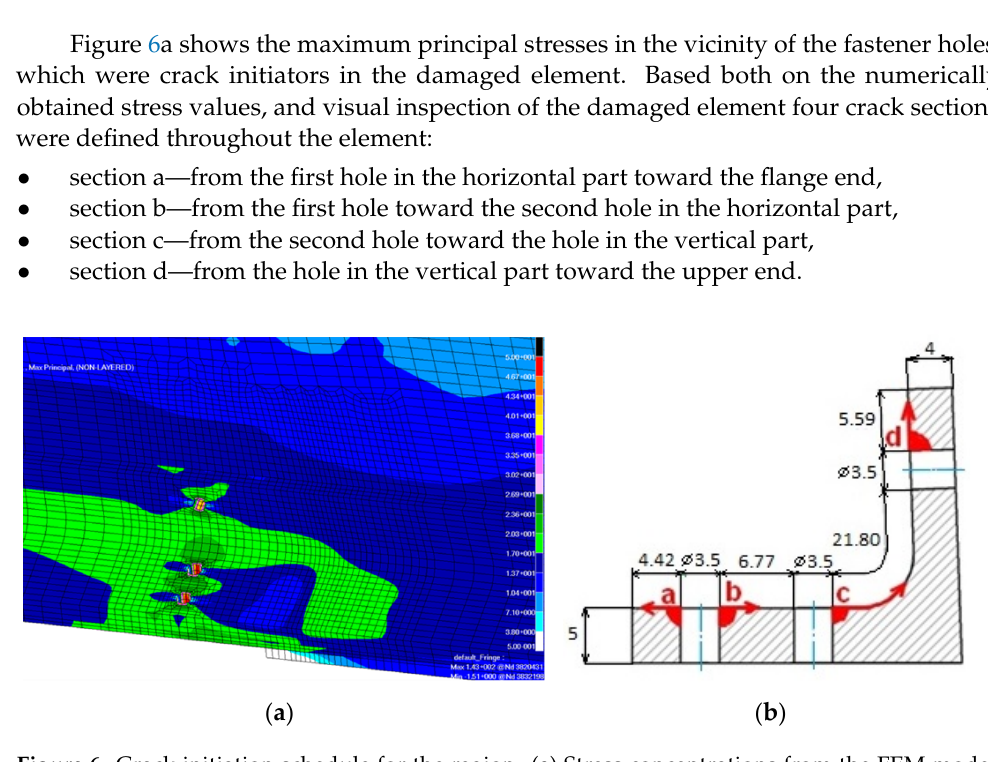
Figure 6. Crack initiation schedule for the region. ( a ) Stress concentrations from the FEM model; ( b ) assumed crack. ( b ) assumed